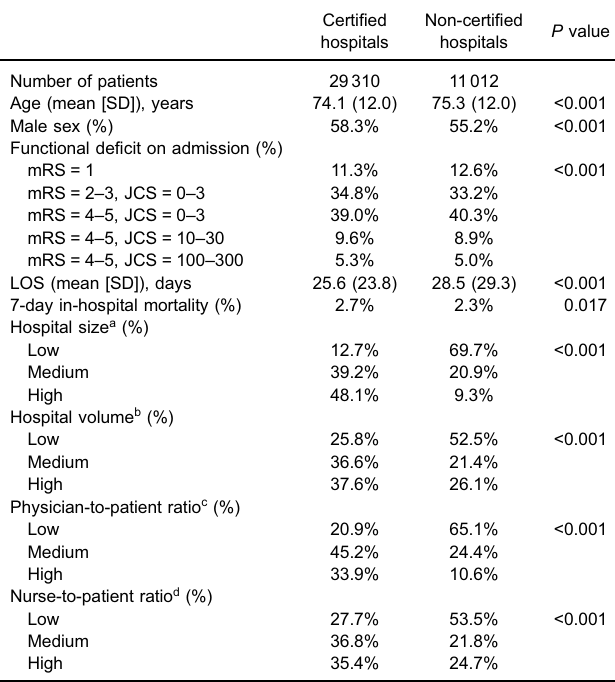
Table 1. Patient characteristics by transfer